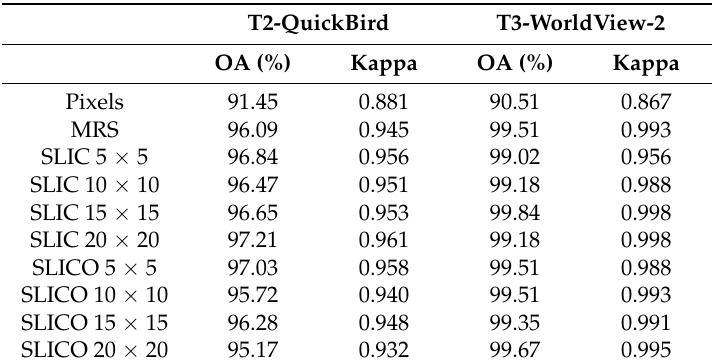
Table 6. Overall accuracy (OA) and Kappa index for T2 and T3 RF classifications, using all ten approaches tested in this